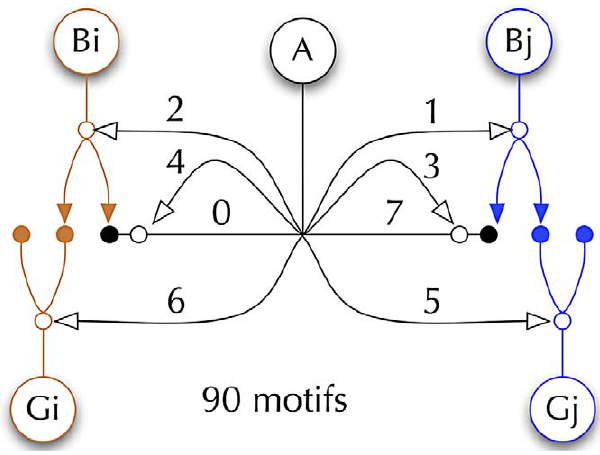
Figure 1. Neuronal Elements for Building Networks (A) Five-element micronetwork involving one AC (A) mediating cross talk between two vertical channels (i, j) with BCs (B) synaptically driving GCs (G). There are eight discrete AC connections (0–7), and the network can be configured in 90 formal motifs, at least 40 of which are of biological significance. Solid dots and arrows are excitatory; open dots and arrows are